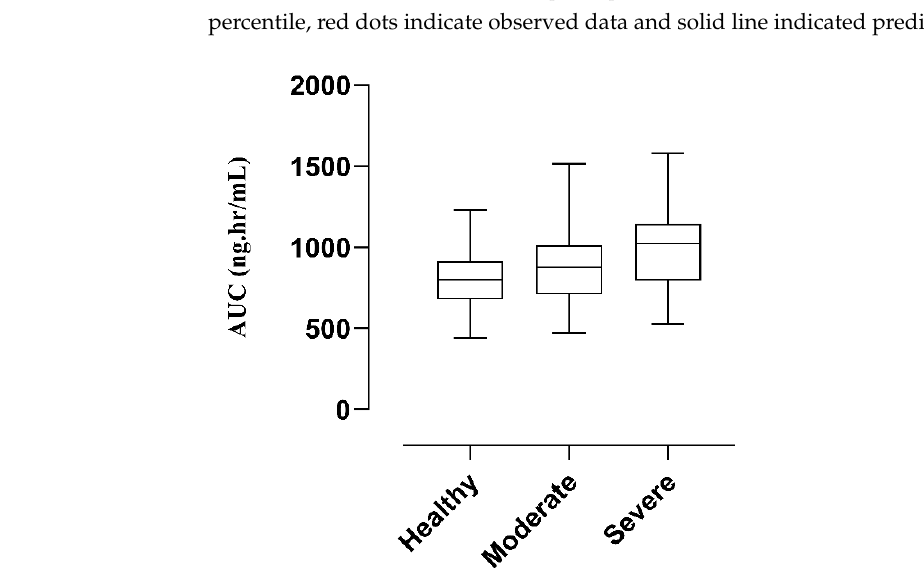
Figure 7. Box-whisker plots after IV (1 mg/kg) dose of labetalol in healthy, moderate kidney failure, and severe kidney failure populations to compare AUC.